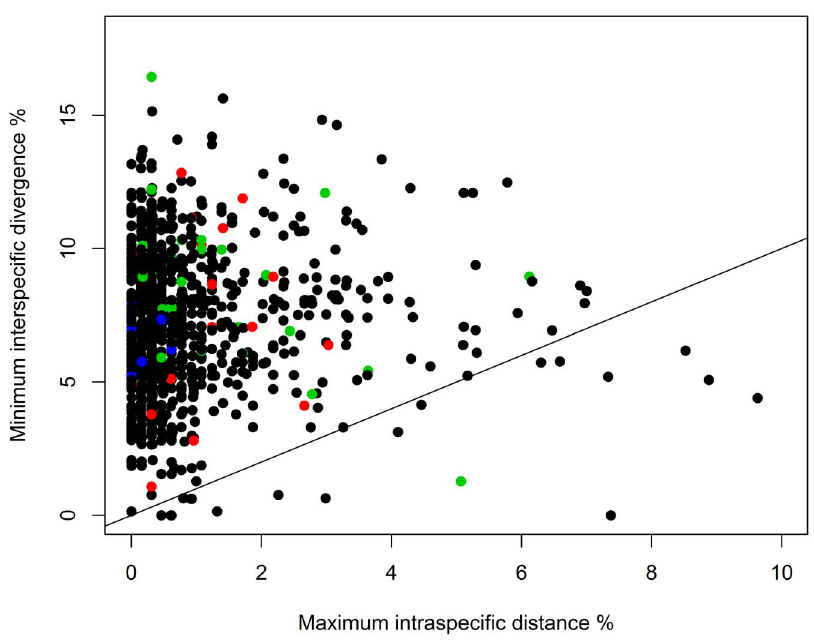
Fig. 3. Maximum intraspecific distance (K2P) for COI plotted against minimum distances to the nearest neighbour (NN) species for the combined Austrian and Finnish data (5777 specimens, 1004 species). The diagonal line represents cases where the maximum intraspecific distance equals the minimum distance to the NN. Colours represent different distribution categories (black: continuous; green: fragmented, red: disjunct, blue: